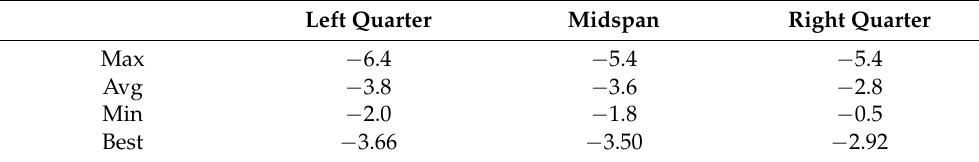
Table 10. M3C2 results using ICP registration.